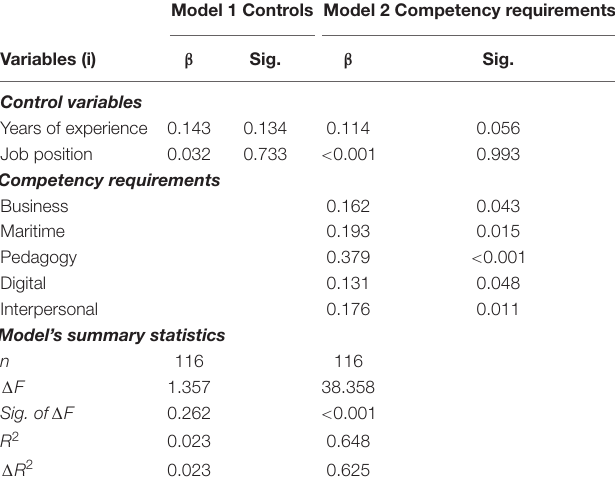
TABLE 7 | Hierarchical regression analysis with perceived teaching performance as dependent